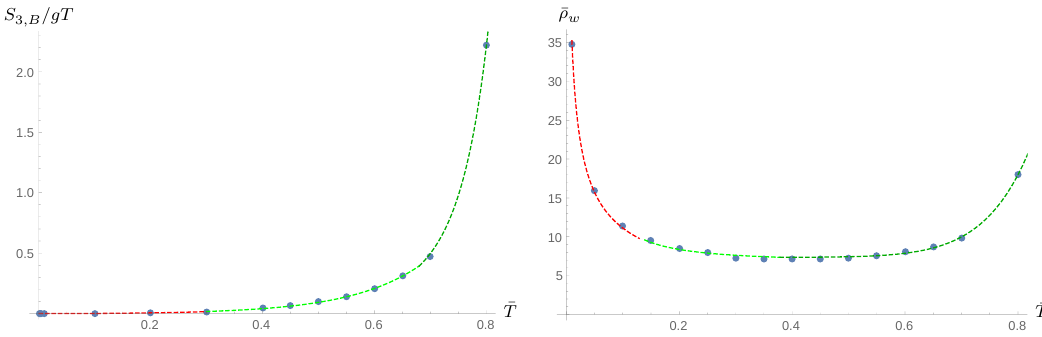
Figure 3 . The action S 3 ,B /gT and dimensionless radius ¯ ρ w of the O(3) symmetric bubble as a function of ¯ T . Dots correspond to numerical results, the dotted lines to eqs. (4.37), (4.38). Different colors correspond to different expressions of the piecewise